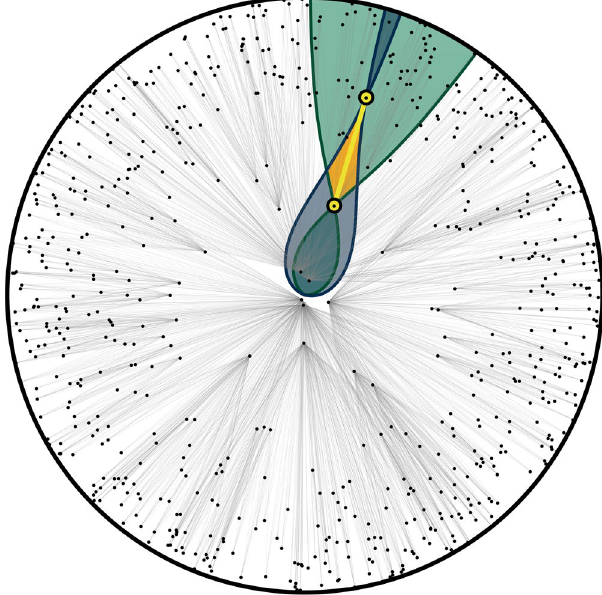
Figure 1. Random geometric graph in (1 + 1)-dimensional de Sitter spacetime. The graph is realized by Poisson sprinkling 700 nodes onto a (1 + 1)-dimensional de Sitter manifold, with compact spatial foliation by circles, which are hypersurfaces of constant time. The temporal cutoff is τ 0 = 5.94, which is the radius of the disk shown. In the figure, the graph has been mapped from the de Sitter manifold to a disk of this radius by equating the time coordinates of all points in de Sitter spacetime with the radial coordinates in the shown disk. A pair of nodes, shown in yellow, is chosen and their light cones are shown in gray and green. The yellow nodes are connected to all other nodes that happen to lie in their corresponding light cones. In particular, the yellow nodes are connected to each other since they lie within each other’s light cones. The overlap between the past and future light cones of the higher- t and lower- t yellow nodes respectively, shown in orange, is their Alexandroff set. The full set of grey links is obtained by iterating over all node